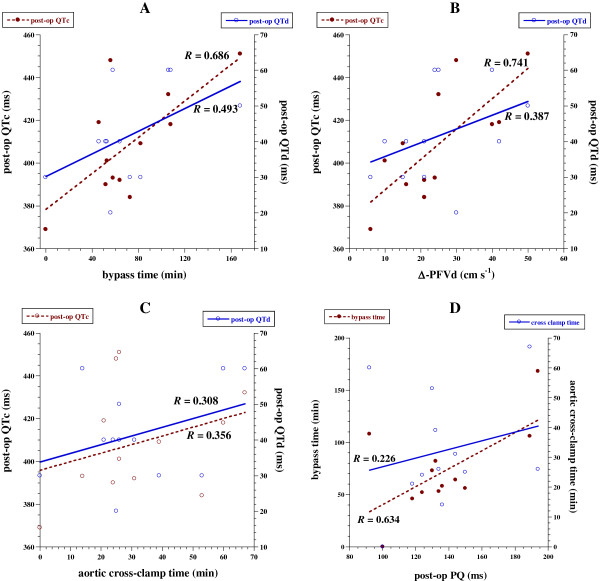
A-D. Correlations between post-operative ECG parameters vs. cardiopulmonary bypass time, Δ-LAD PFV and aorta cross clamp time. A; Correlation between post-op QTc and QTd and bypass time. B; Correlation between post-op QTc and QTd and Δ-LAD PFV. C; Correlation between post-op QTc and QTd and aortic cross-clamp time. D; Correlation between post op PQ duration and bypass time and aortic cross-clamp time.